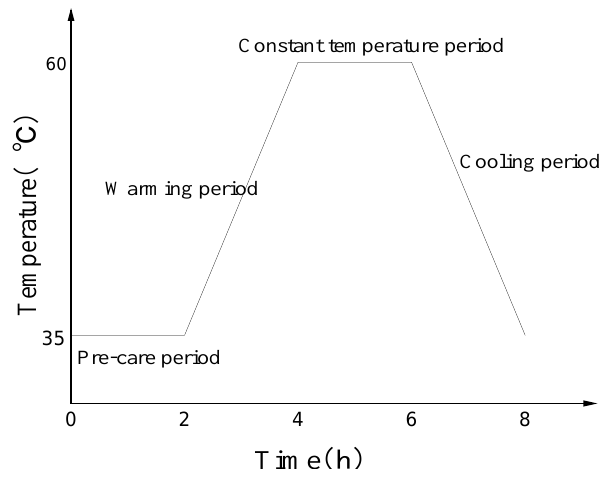
Figure 1. Steam-curing system.